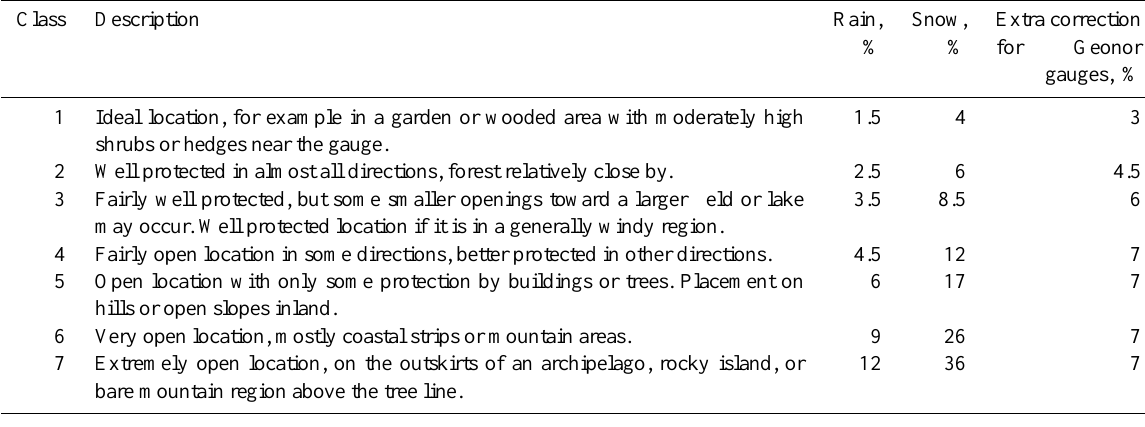
Table 5. Classification of precipitation stations and correction factors based on exposure to wind. Class